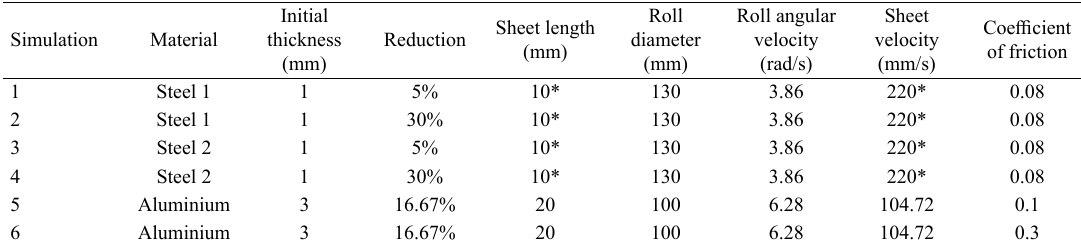
Table 1. Simulations chosen from the literature 11,24